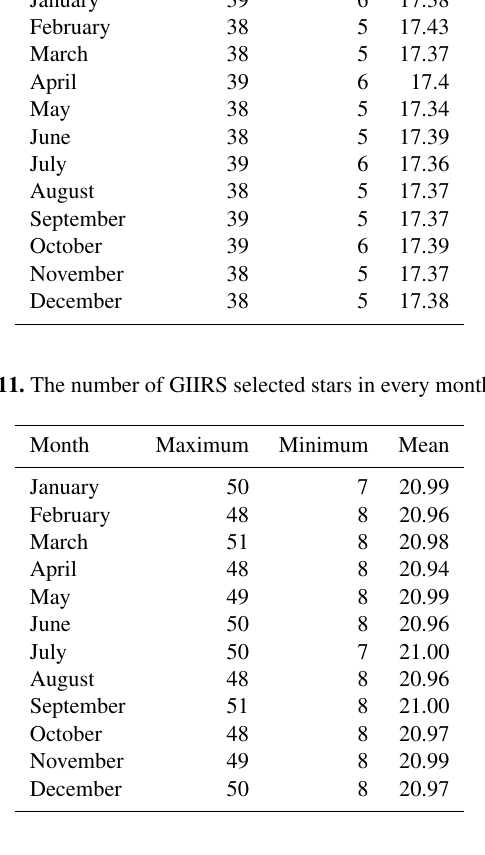
and 6 give three different examples of AGRI and GIIRS star selection, respectively, in which five stars are set as the goal. The outer frame represents the instruments’ observation range, where the abscissa represents scanning angle and the ordinate represents stepping angle. Figures 5a and 6a show the case of too meany stars that can be selected. Figures 5b and 6b show the case of neither too many nor too few